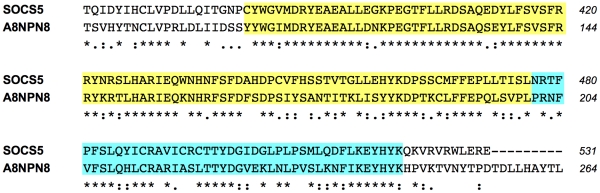
ClustalW alignment of the candidate mimicry region in A8NPN8 from B. malayi to H. sapiens SOCS5.The SH2 domain is shaded in yellow, the SOCS box domain in blue. The N-terminal parts of the two proteins do not share any similarity (not shown).